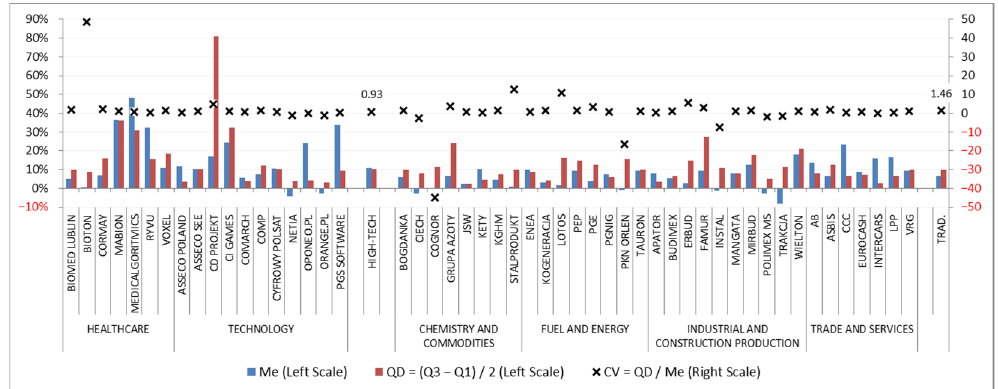
Figure 6. Assessment of changes in operating costs in the surveyed enterprises . Source: own work.